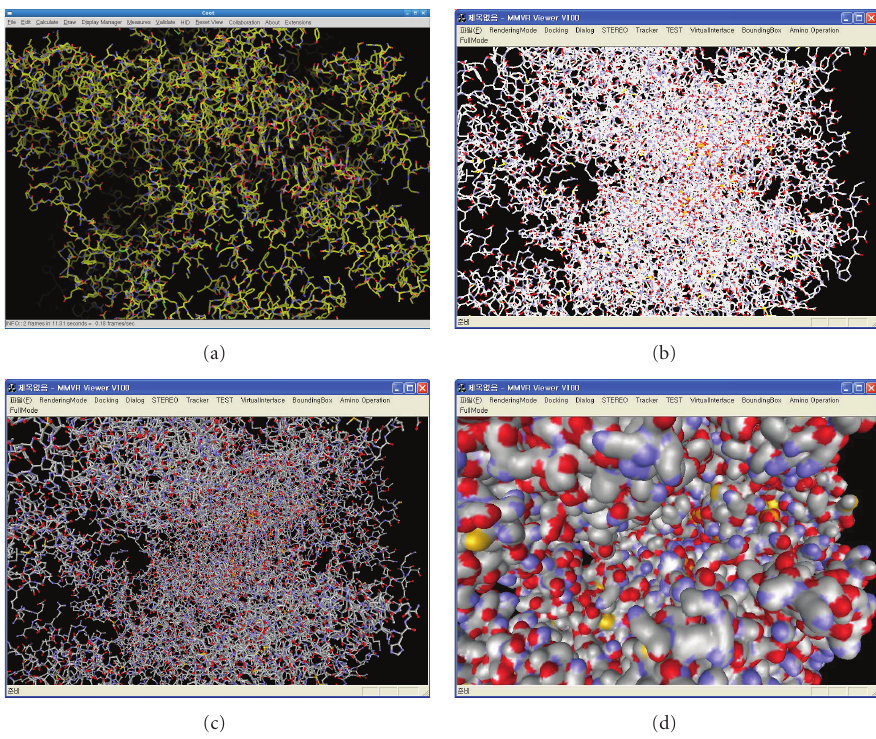
Figure 3: Results of visualization of 1SFO [14] (a) in the wire frame mode in Co-Coot, (b) in the wire frame mode in VRMMS, (c) in the ball and stick mode in VRMMS, and (d) in the surface mode in VRMMS.